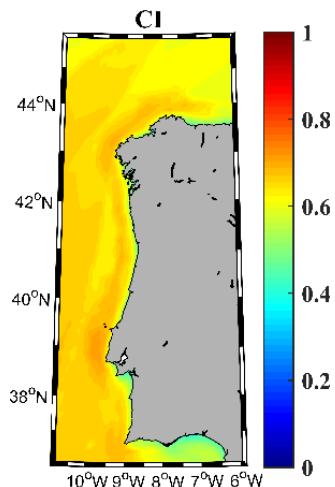
Figure 11. Classification of the combined wind-wave energy resource in the NW Iberian Peninsula for the near future (2026–2045).